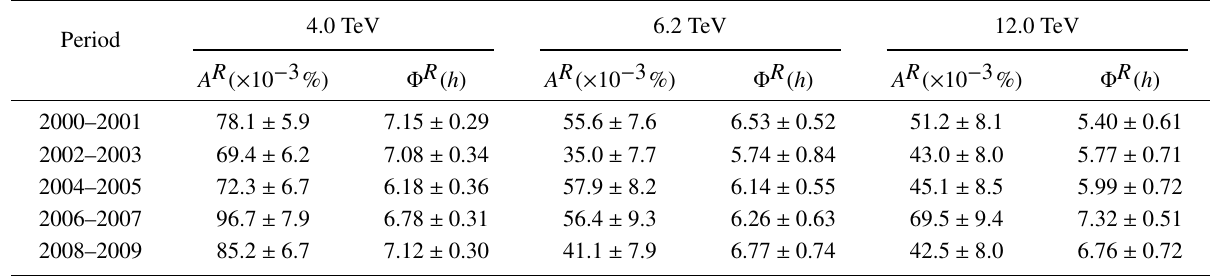
Table 1: Amplitudes and Phases of the Multi-TeV Mean Solar Diurnal Variation Observed by Tibet in 2000–2009